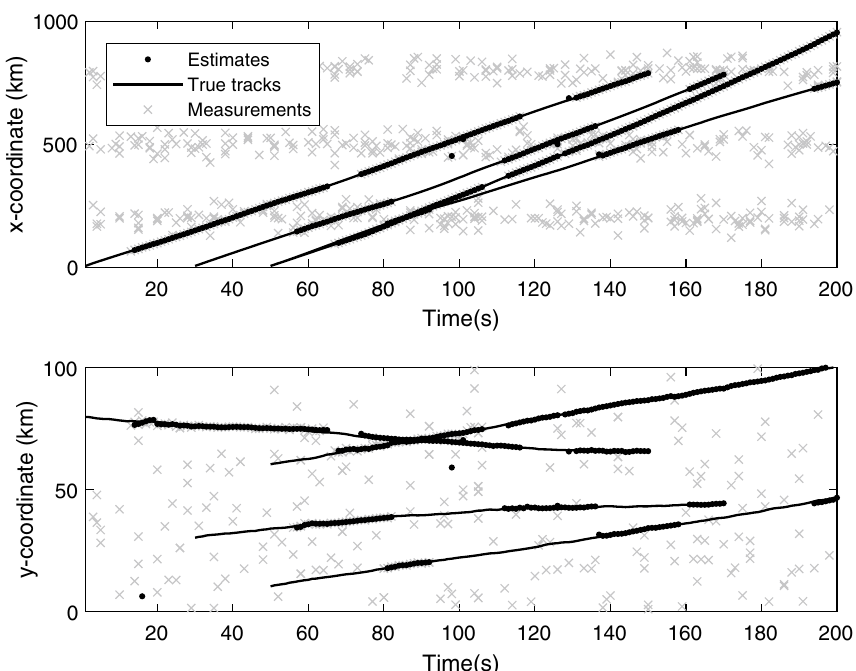
Fig. 4 The true tracks vs. estimated tracks in x , y